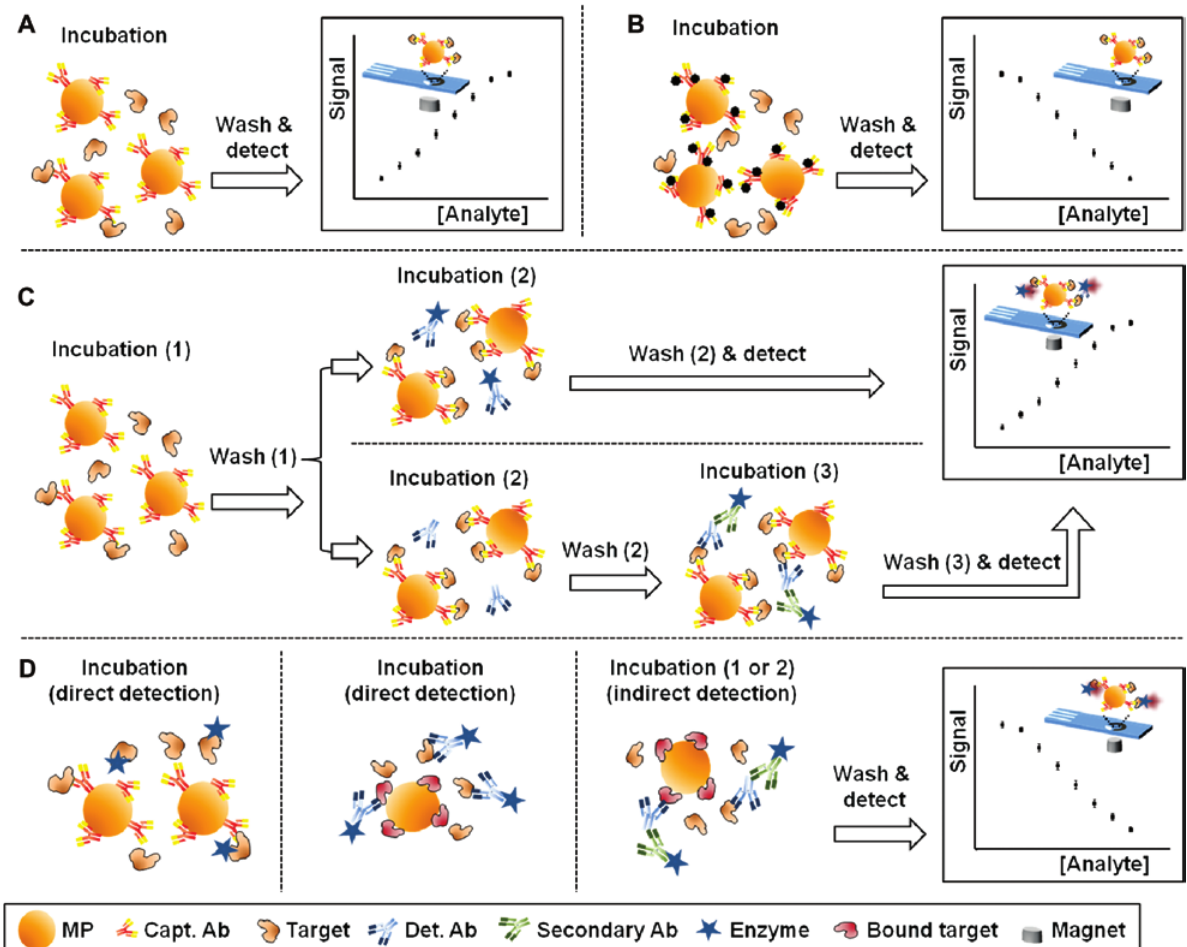
Figure 5: Examples of magnetoimmunoassay format. (A) Direct electrochemical detection of analytes that display electroactive or enzymatic behavior. Signal registered will be proportional to analyte concentration. (B) Direct electrochemical detection of nonelectroactive analytes using MP modified with Ab and an electroac- tive label. Signals inversely proportional to analyte concentration will be registered. (C) Sandwich immunoassay coupled to either direct detection (i.e. using an anti-target-labeled Ab) or indirect detection (i.e. using an unmodified anti-target IgG plus an anti-IgG-labeled Ab). (D) Three different formats of competition